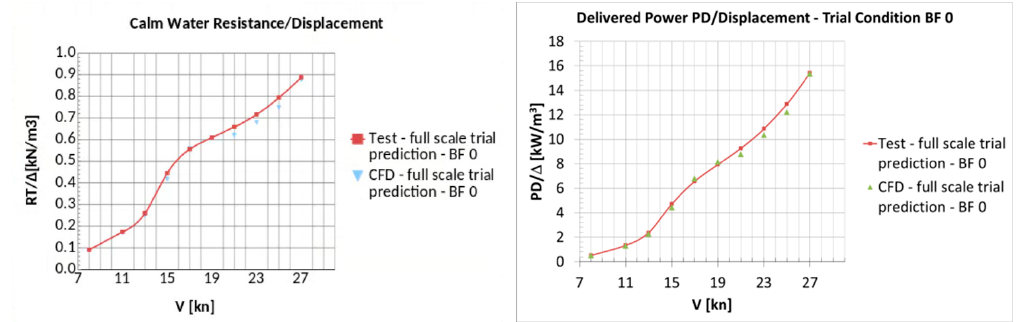
Figure 9. Comparison on calm water resistance ( left ) and delivered power ( right ) per displacement between model tests and full scale CFD for the Stavanger Demonstrator.